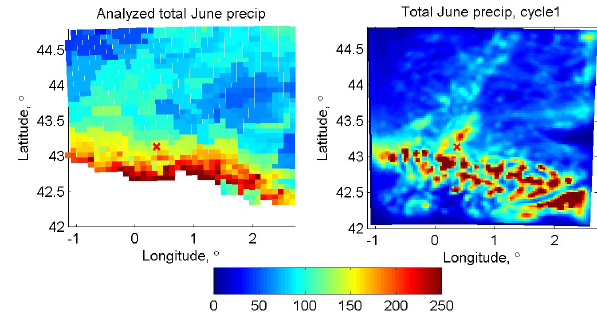
Figure 8. Analyzed (left) and modeled precipitation total (mm) for the month of June in the first